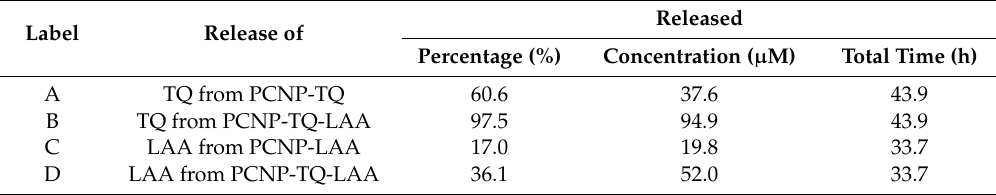
Table 5. Release percentage and concentration of thymoquinone (TQ) and l -ascorbic acid (LAA) from PCNP